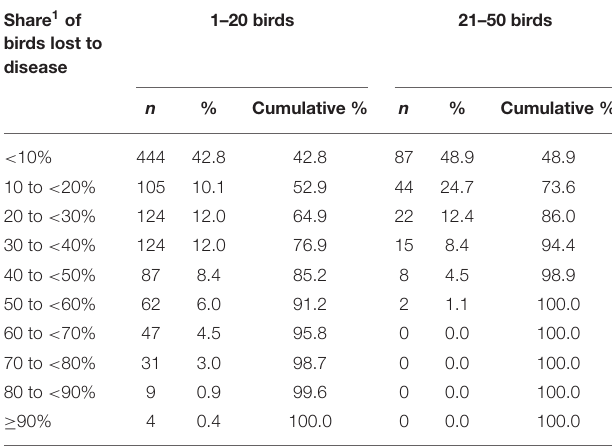
TABLE 6 | Frequency distribution of value of birds lost to disease as proportion of annual household income for flocks of 1–20 and of 21–50 birds. Value of birds lost as share of